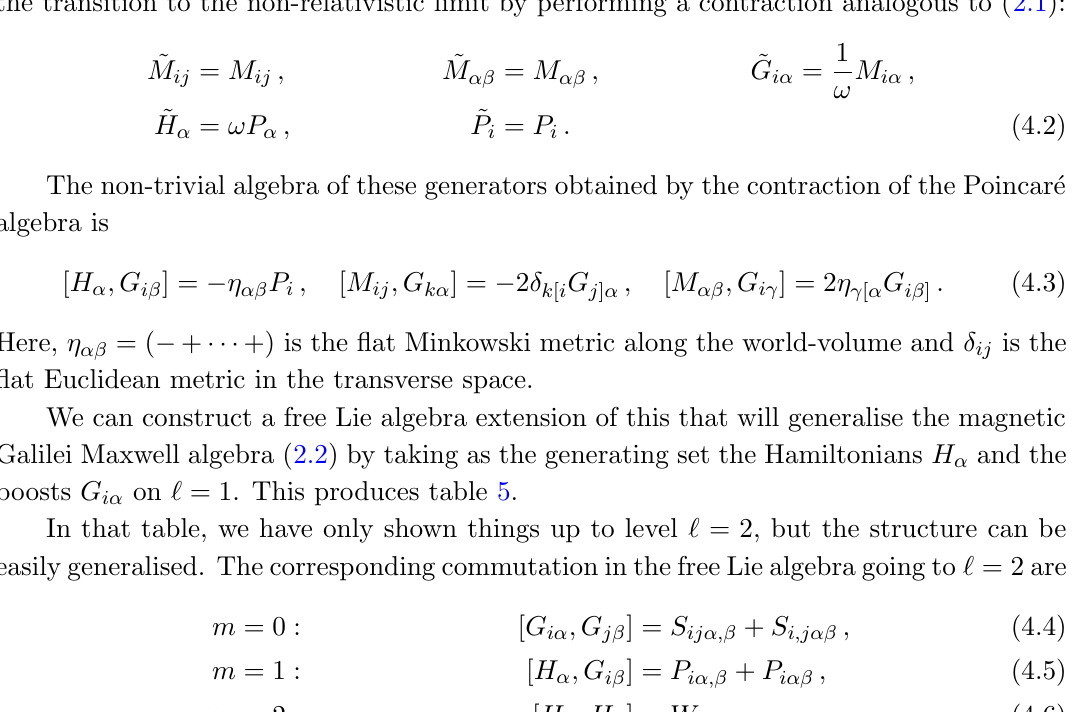
in (cid:11)(cid:12)